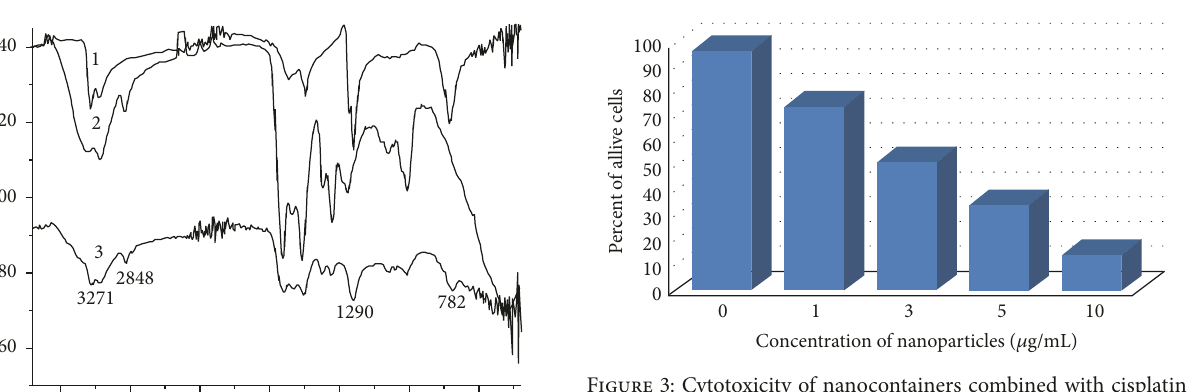
Figure 3: Cytotoxicity of nanocontainers combined with cisplatin (D-g-PAA(PE)/cisplatin) for the J774 cells. The data presented here are obtained by using Trypan Blue